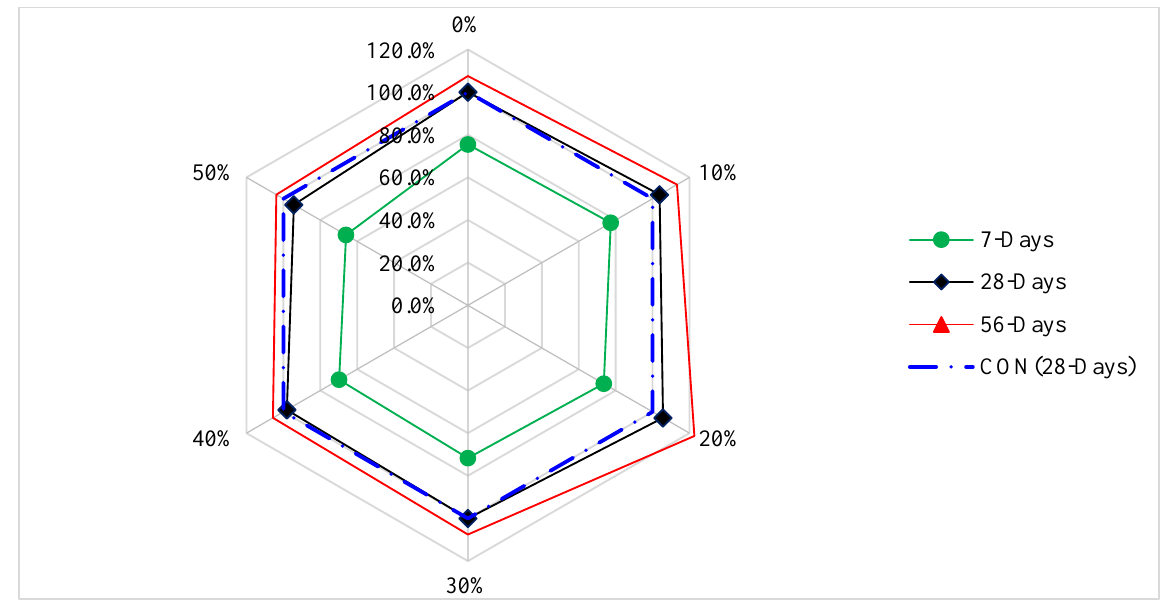
Figure 9. Strength – age relation of CS (data source [36]). Figure 9. Strength–age relation of CS (data source